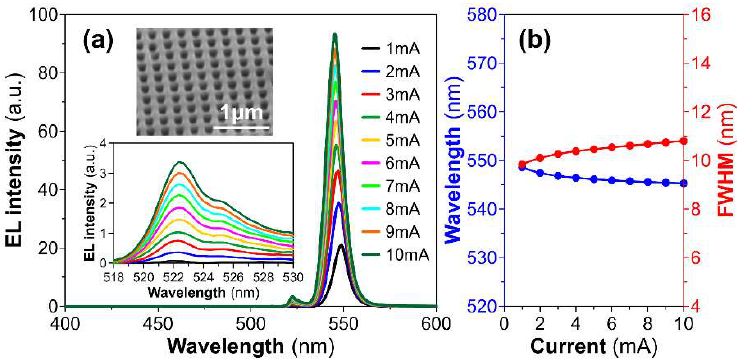
Figure 5. ( a ) Measured electroluminescence spectra for the injection current increases from 1 to 10 mA. ( b ) Current-dependent peak wavelengths and FWHMs of the fabricated green µ-PCLED with a mesa diameter of 30 µm. The insets in Figure 5a show the SEM image of the p-GaN PC and zoom-in picture of spectra for minor peaks.